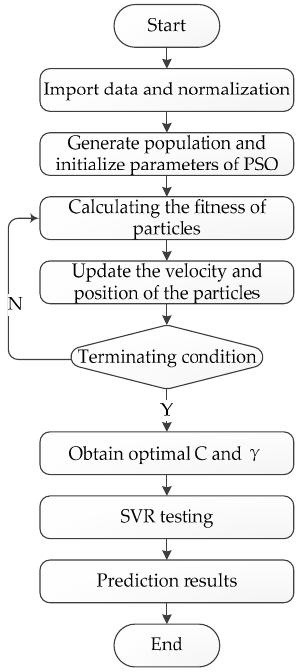
Figure 2. Particle swarm-optimized support vector regression (SVR) algorithm flow chart.